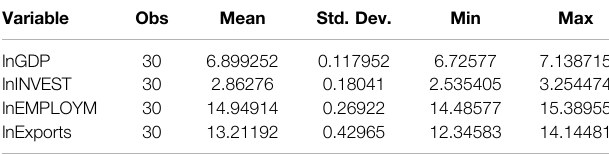
TABLE 2 | Summary statistics for